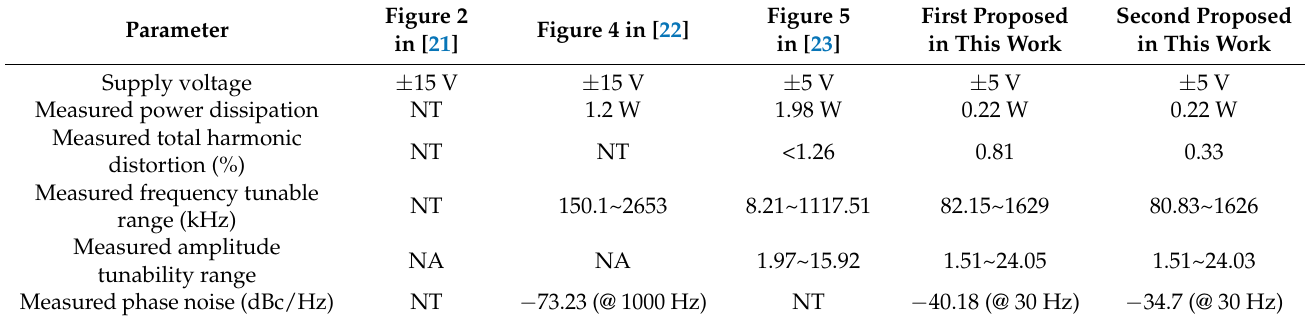
Table 3. The additional performance comparisons with previous VM